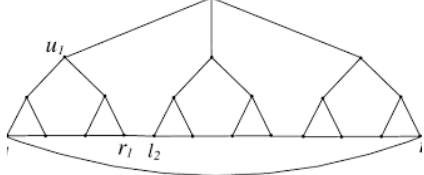
Figure 5. A Christmas tree CTN ( 3 ) with 3